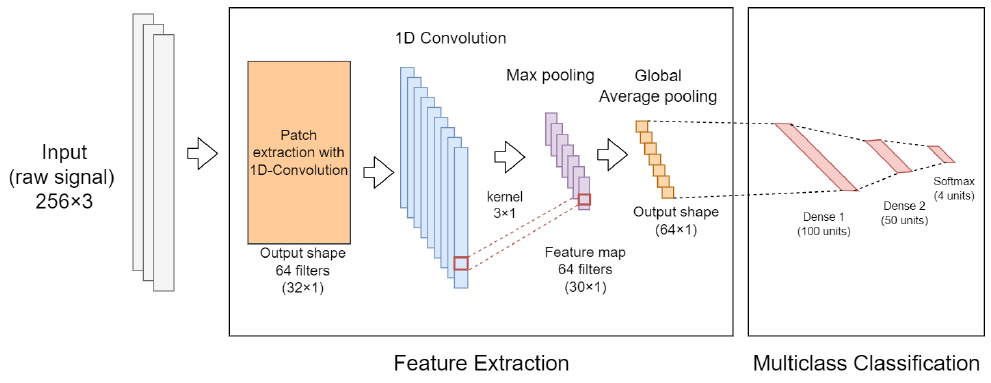
Figure 6. Proposed architecture for a CNN with patch input and